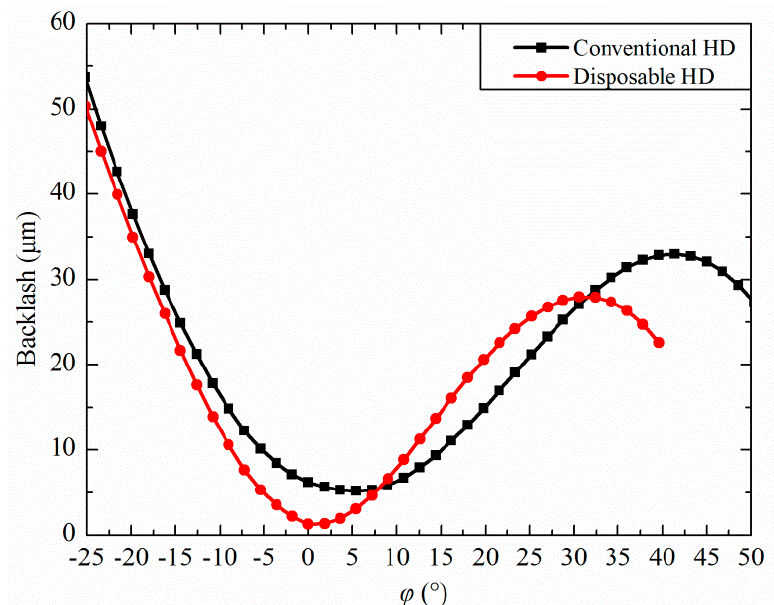
Figure 6. Backlash under no load of two kinds of HDs. On the basis of Equations (11)–(14), the no-load backlash of the HDs is related to parameters ∆ ϕ and r m . As shown in Figure 6, the minimum no-load backlash of the conventional HD occurs near the polar angle of ϕ = 5 ◦ . However, since the disposable flexible wheel structure does not contain a cylinder and has a thinner rim, the minimum no-load backlash of the disposable HD occurs at the midline of the major axis and is lower than that of the conventional HD. The difference between backlash distribution directly affects the load distribution and contact characteristics of the harmonic